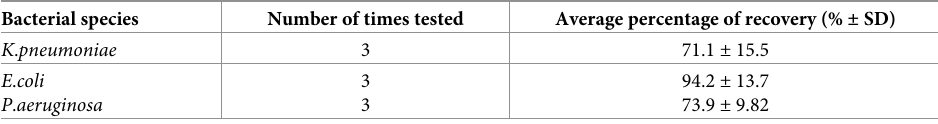
� Optimized hybridization condition using a hybridization buffer containing 30% formamide with a probe concentration of 200 nM, hybridized for 15 minutes at